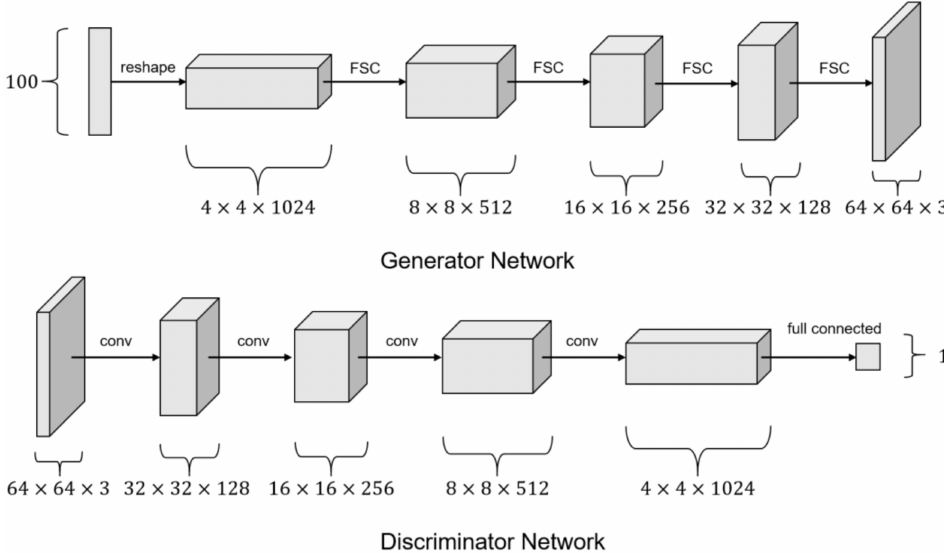
Figure 5. The architecture of the generator and the discriminator in a DCGAN model. FSC is the abbreviation of fractionally-strided convolution; conv is the abbreviation of